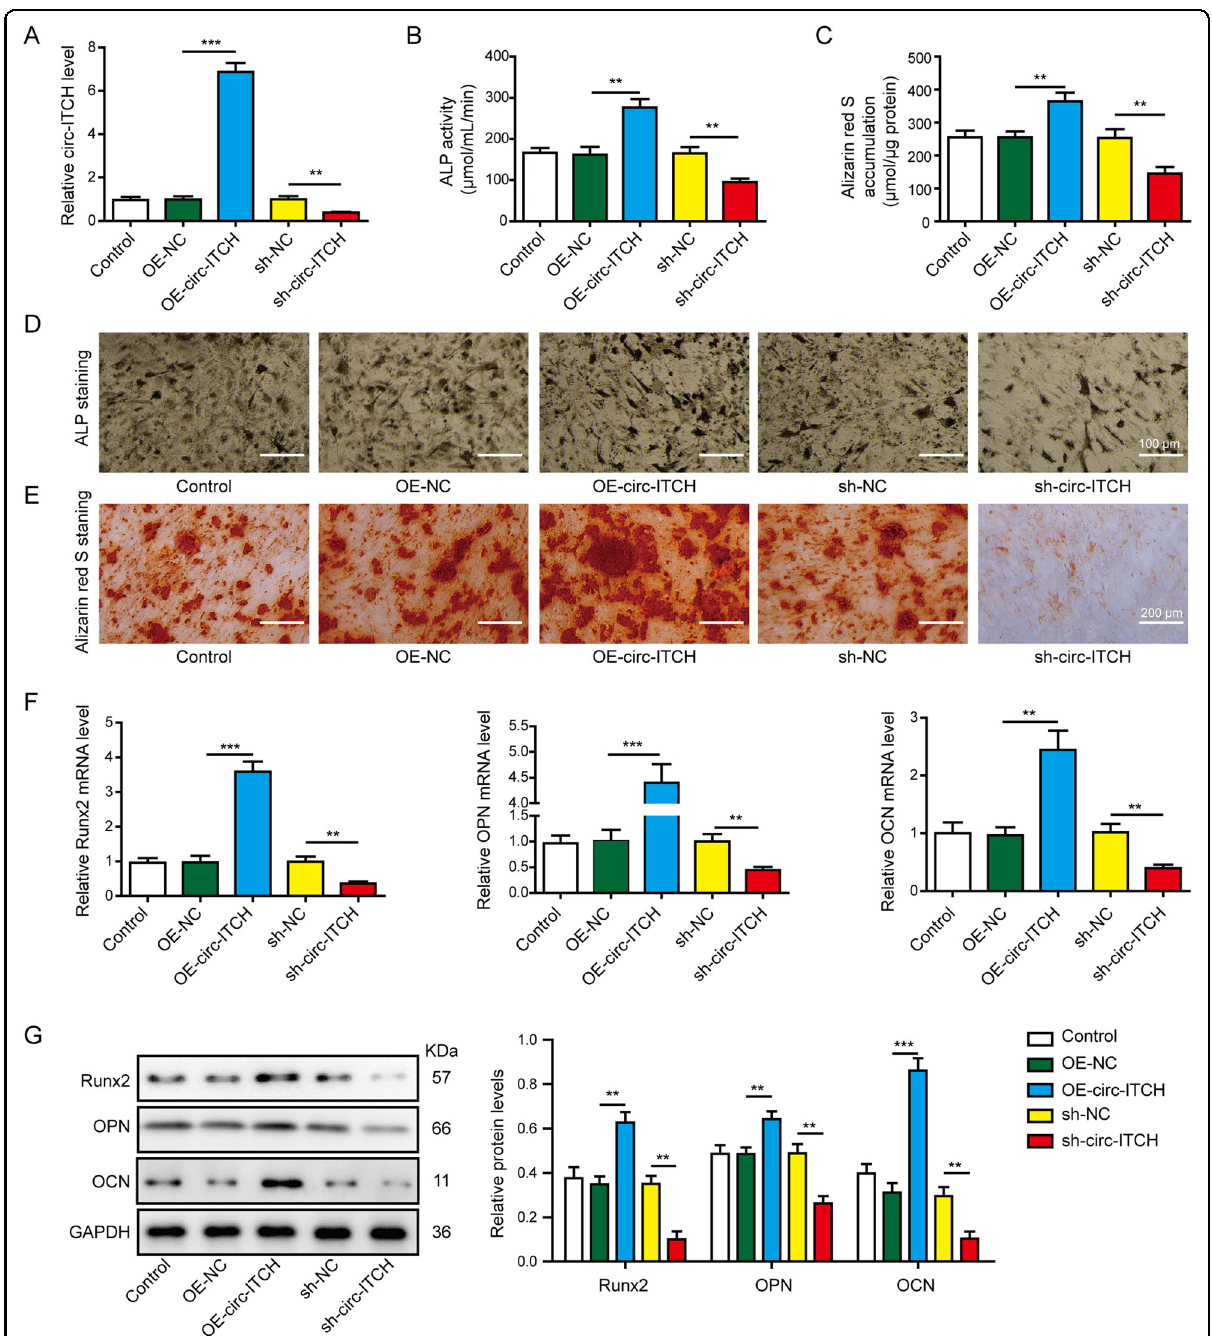
Fig. 2 Circ-ITCH promoted the osteogenic differentiation of hBMSCs in vitro. hBMSCs were transfected by lentiviruses to overexpress circ-ITCH or knockdown circ-ITCH. A The transfection ef fi cacy of OE-circ-ITCH and sh-circ-ITCH lentivirus vectors were veri fi ed by RT-qPCR. B ALP activity of hBMSCs at day 14 after osteogenic differentiation. C Alizarin red S accumulation in hBMSCs at day 14 after osteogenic differentiation. D ALP staining of hBMSCs at day 14 after osteogenic differentiation. Scale bar: 100 μ m. E Alizarin red S staining in hBMSCs at day 14 after osteogenic differentiation. Scale bar: 200 μ m. F , G The mRNA and protein levels of RUNX2, OPN, and OCN were determined by RT-qPCR and western blot assay at 14 day after osteogenic differentiation. ** P < 0.01 and *** P <